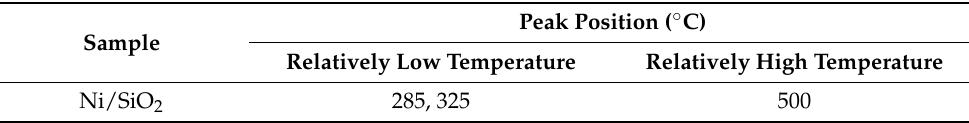
Table 1. Results of H 2 -TPR of the prepared Ni/SiO